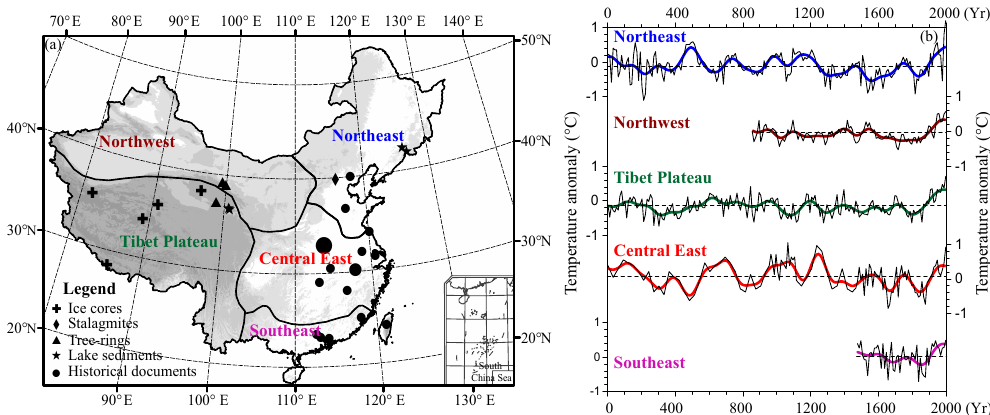
Fig. 1. Spatial distribution of the cited temperature proxy series (a) and temperature changes at a centennial timescale (5-point FFT filter) in five regions of China (Northeast, Central East, Southeast, Northwest, and the Tibet Plateau) ( b ). The temperature anomaly in the right-hand plot is the temperature departure from the 1851–1950 average. The decadal series are from Ge et al. (2010) and are updated for the Tibet Plateau and Northwest China. Dashed lines indicate the overall mean value for each temperature series.